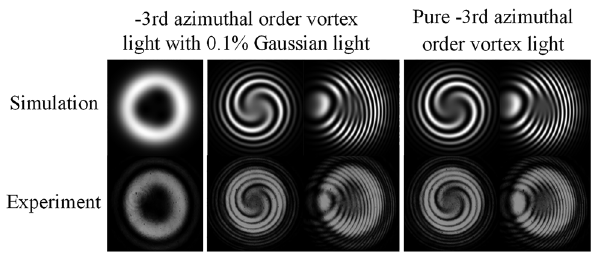
Figure 9: Intensity patterns and interference patterns for the structuredlightconsistingofa − 3rdazimuthalordervortexlightand a Gaussian light under the intensity ratio of 1000:1 and a pure − 3rd azimuthal order vortex